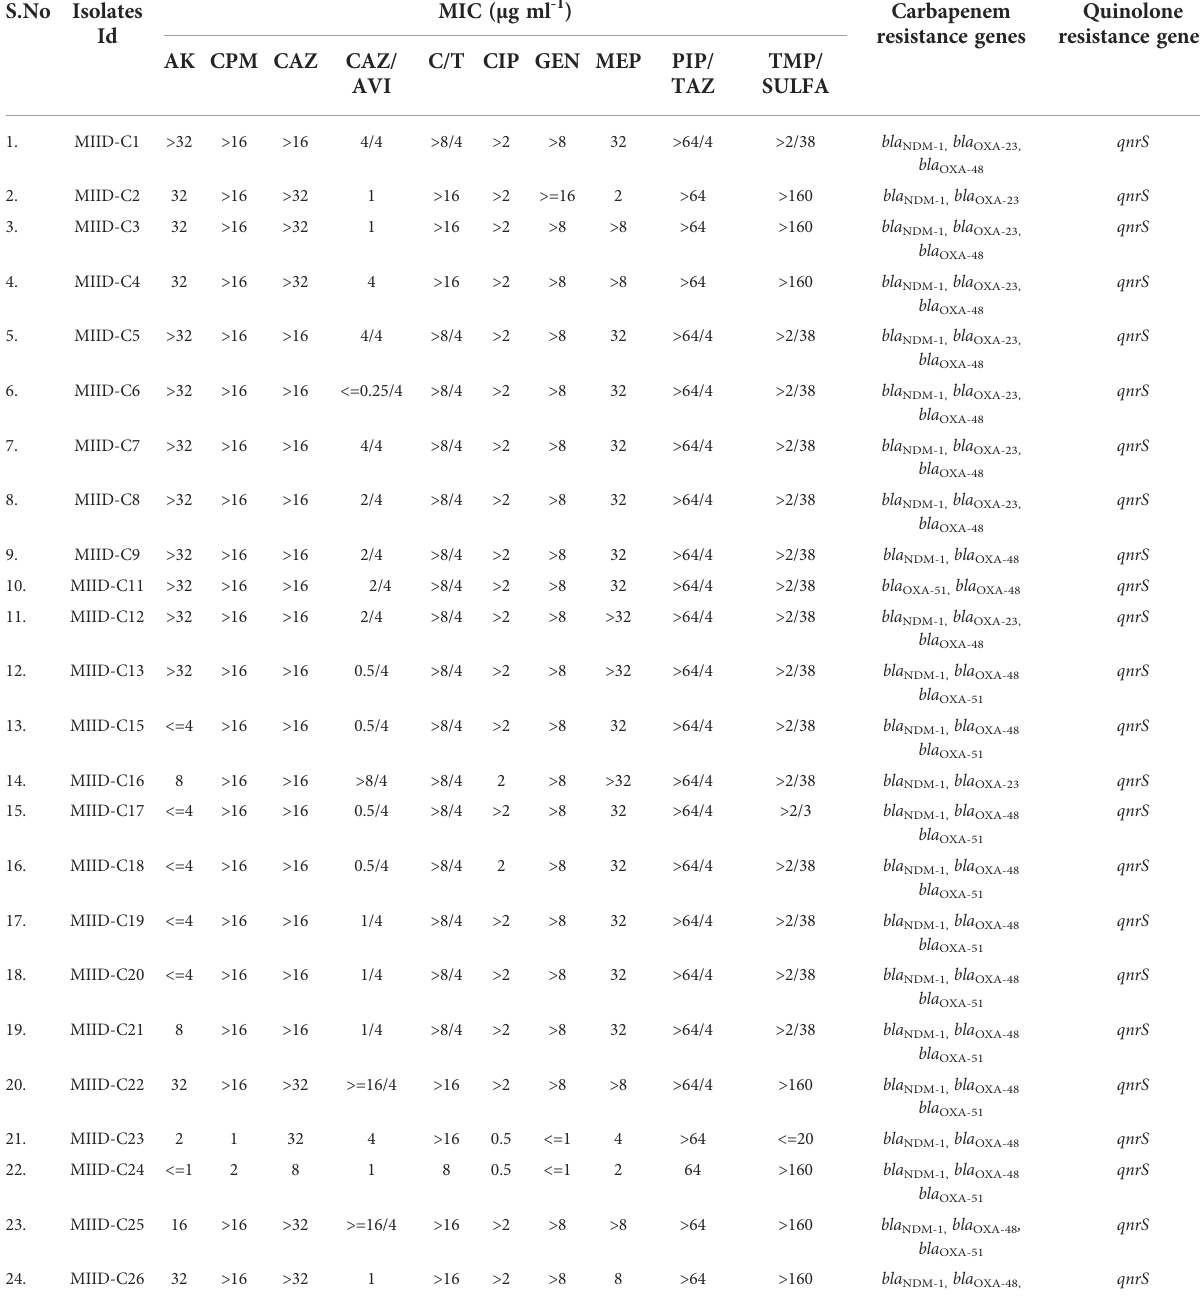
TABLE 1 Minimum Inhibitory Concentrations (MICs) distribution of respective antibiotics in carbapenem-resistant Klebsiella pneumoniae (CRKP) clinical isolates tested in the